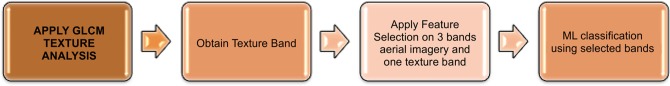
Applying GLCM Texture Analysis to Aerial Imagery.